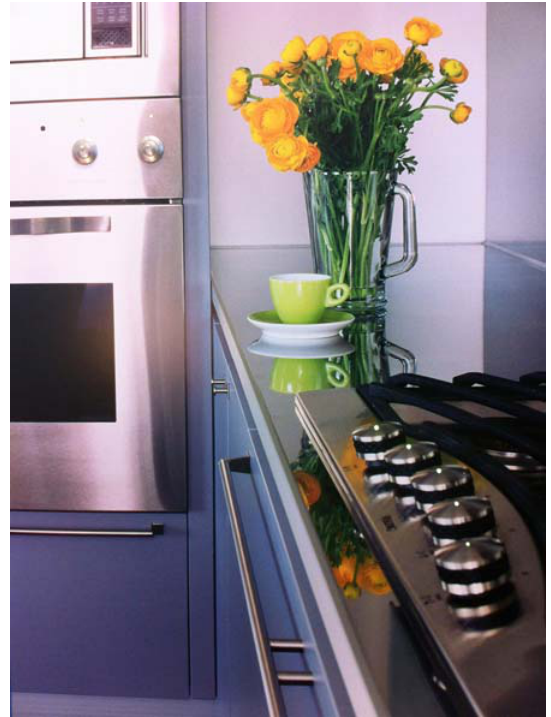
Figure 7. The CNR Domotics Lab Demo